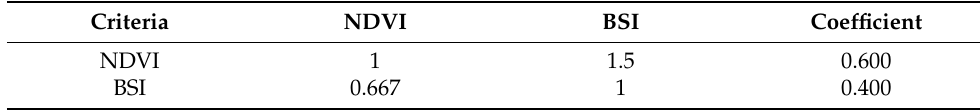
Table 6. Matrix of vegetation sub